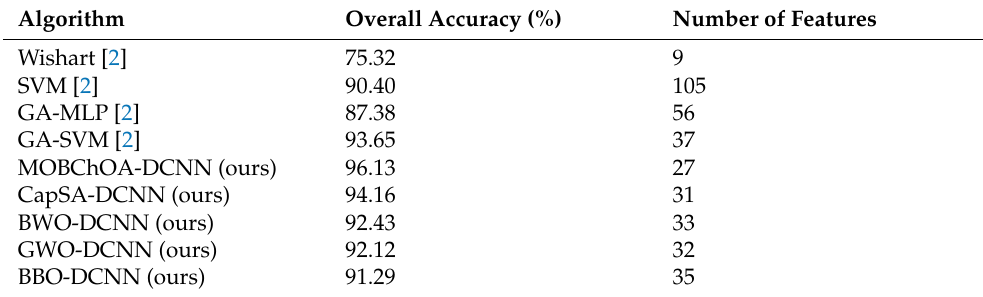
Table 8. Comparison of the results of this paper and previous research